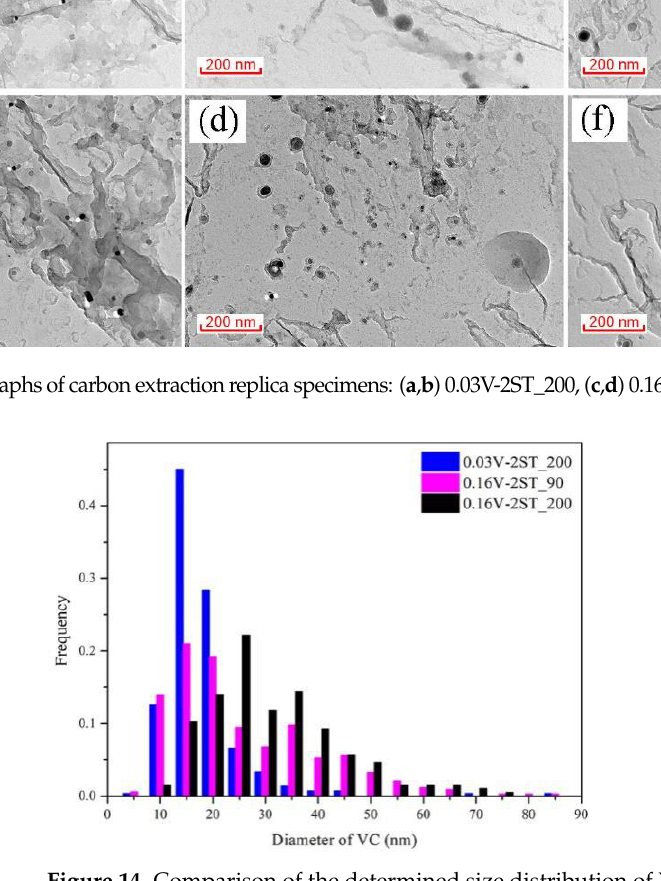
Figure 14. Comparison of the determined size distribution of VC in Q&P-treated specimens: Table 4. Measured 𝐷 𝑚𝑖𝑛 , 𝐷 𝑚𝑎𝑥 , 𝐷 𝑎𝑣𝑔 (nm), and density of VC precipitates (number/μm 2 ) in Q&P-treated steels.